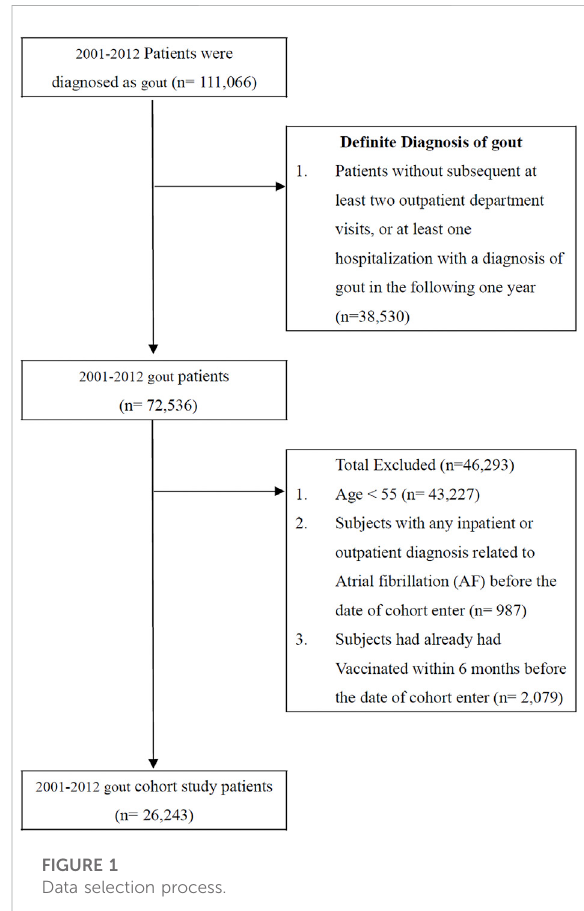
FIGURE 1 Data selection